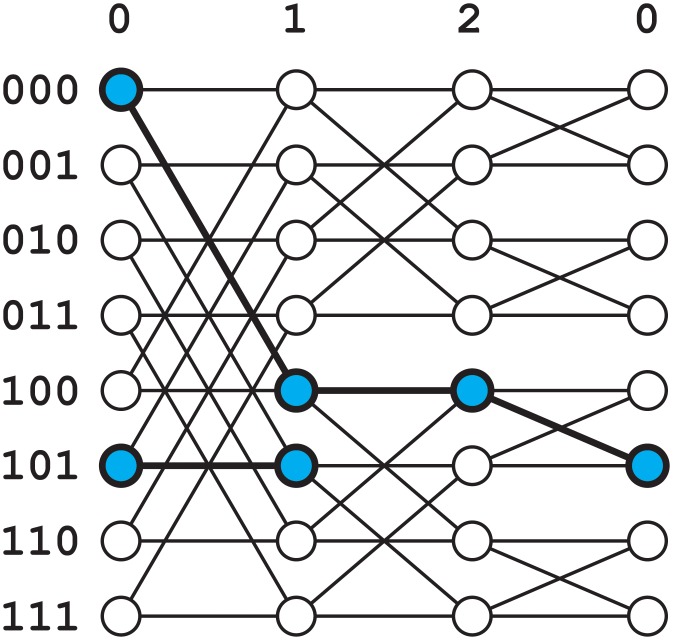
A 3-dimensional wrap-around butterfly network.Note that the rightmost nodes are the same nodes as the leftmost, drawn twice for visual clarity. The highlighted nodes and edges show the path from node (0,000) to node (1,101).